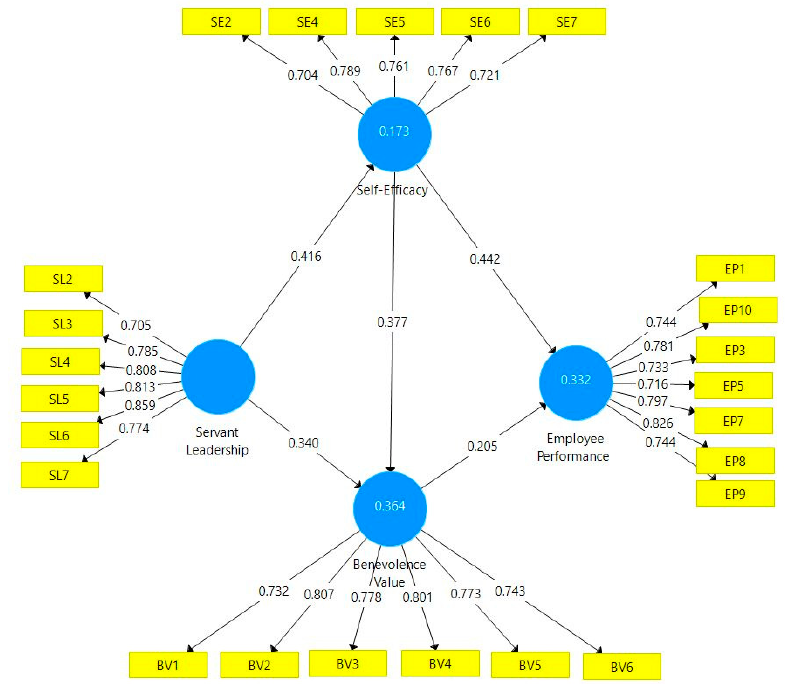
Figure 3. Adjusted measurement model.